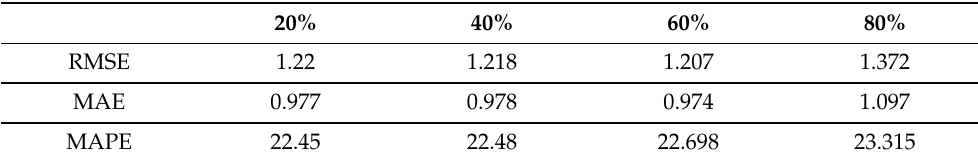
Table 9. Xception model weight experimental result table.